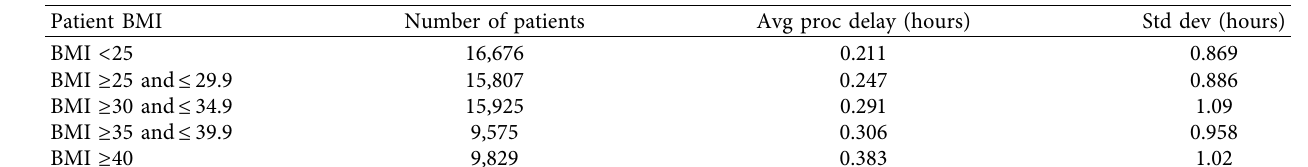
Table 2: Summary statistics of procedure delays with respect to patient BMI.